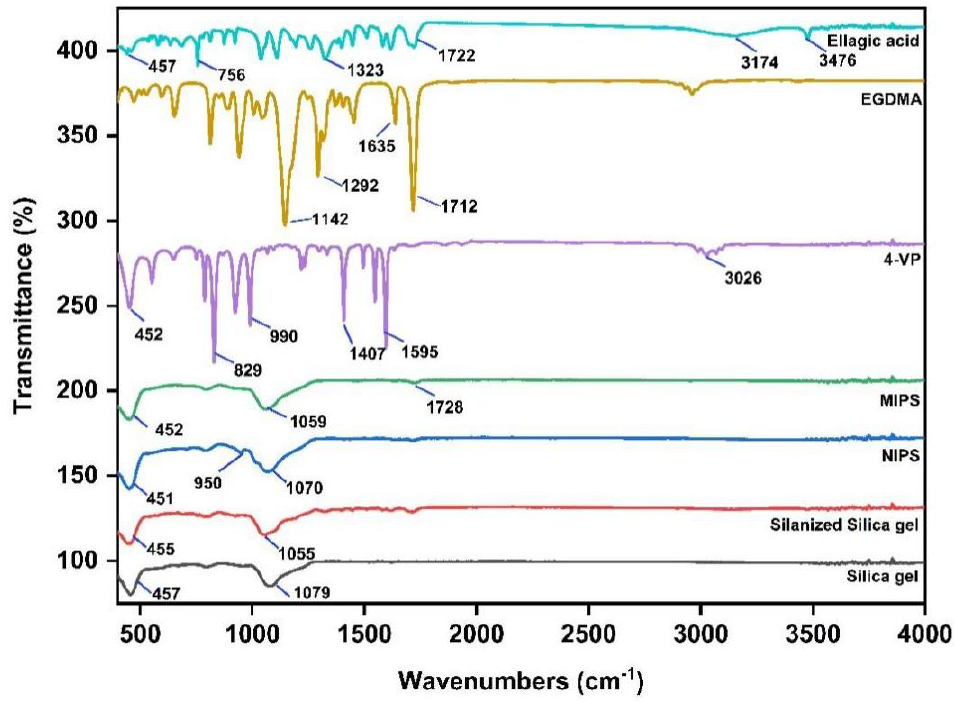
Figure 1. The FTIR spectra of silica gel, silanized silica gel, 4-VP, EGDMA, EA, MIPS and NIPS